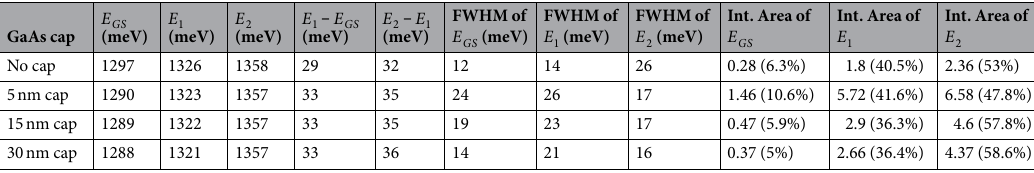
Table 2. Measured PL emission spectrum and results obtained by fitting.